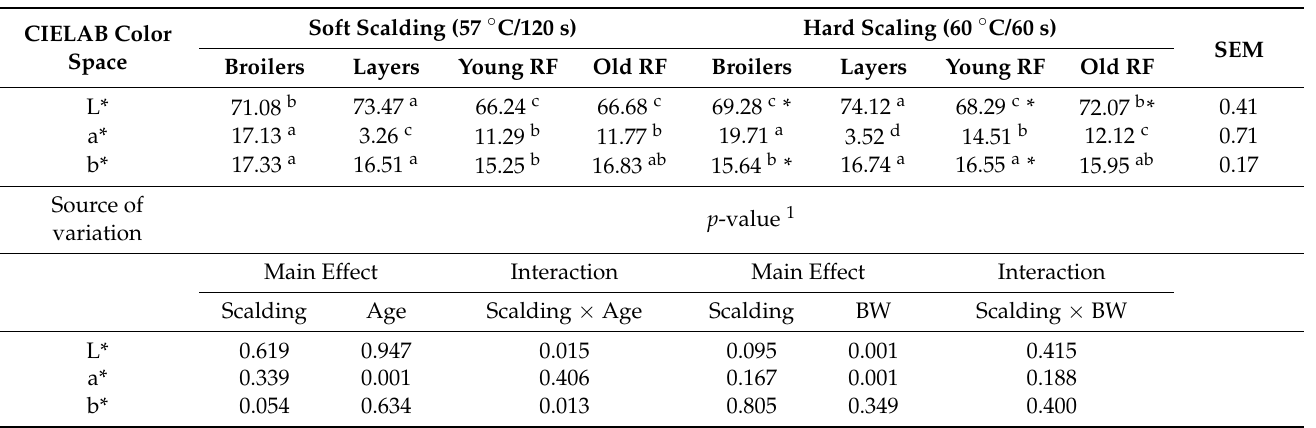
Table 3. Effects of soft and hard scalding on breast skin color of different breeds of